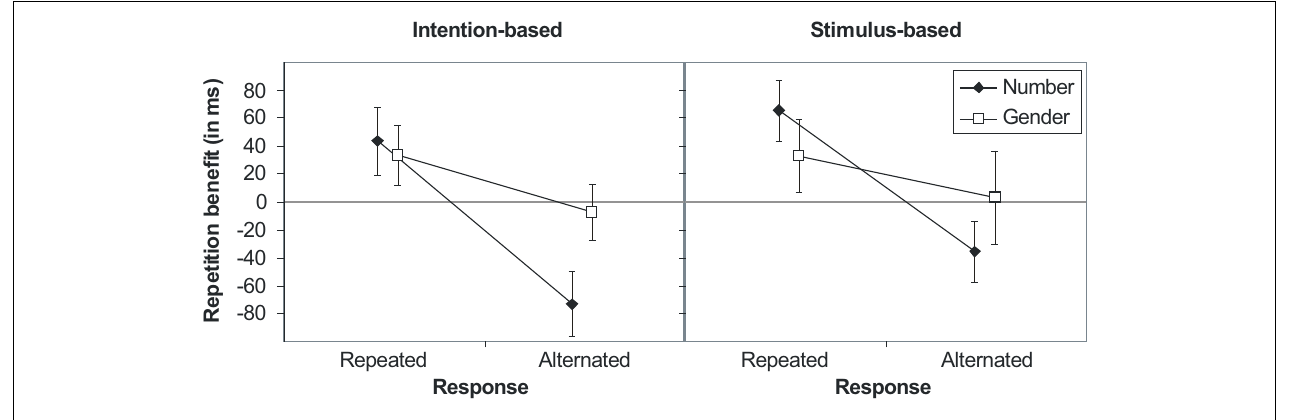
relation (R1–R2 repetition or alternation). Error bars represent the 95% confidence interval of individual means. If error bars do not cross the midline, the repetition benefit (or cost) is significantly different from zero ( p < 0.05).